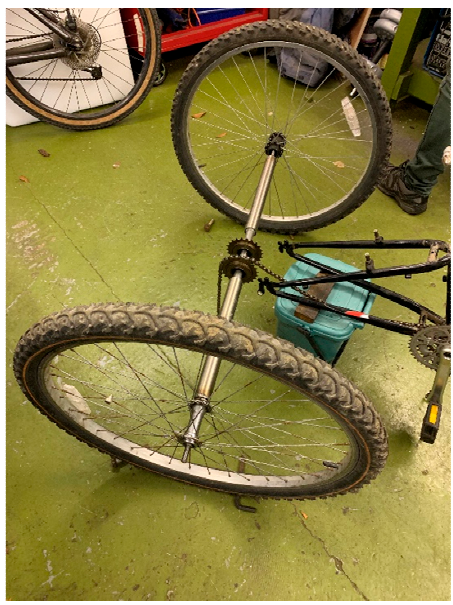
Figure 11. Rear shaft and axle assembly.